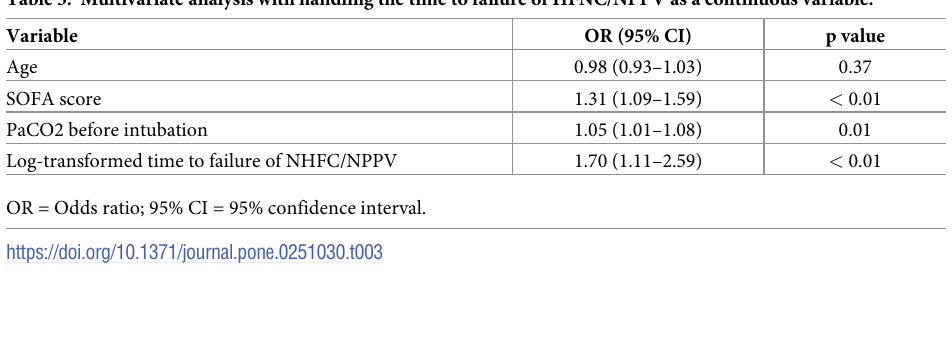
Table 3. Multivariate analysis with handling the time to failure of HFNC/NPPV as a continuous variable. Variable